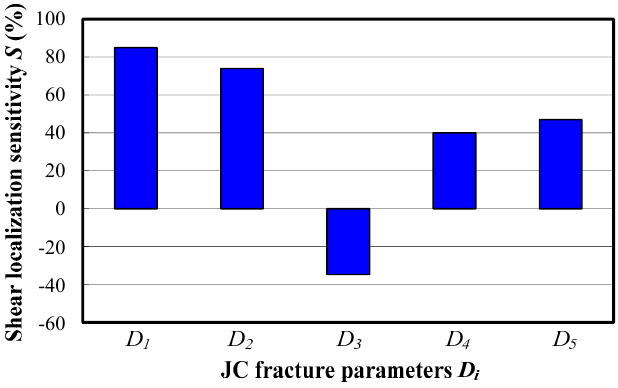
Figure 12. Variations of chip shear localization when the respective fracture parameter D i equals to zero.